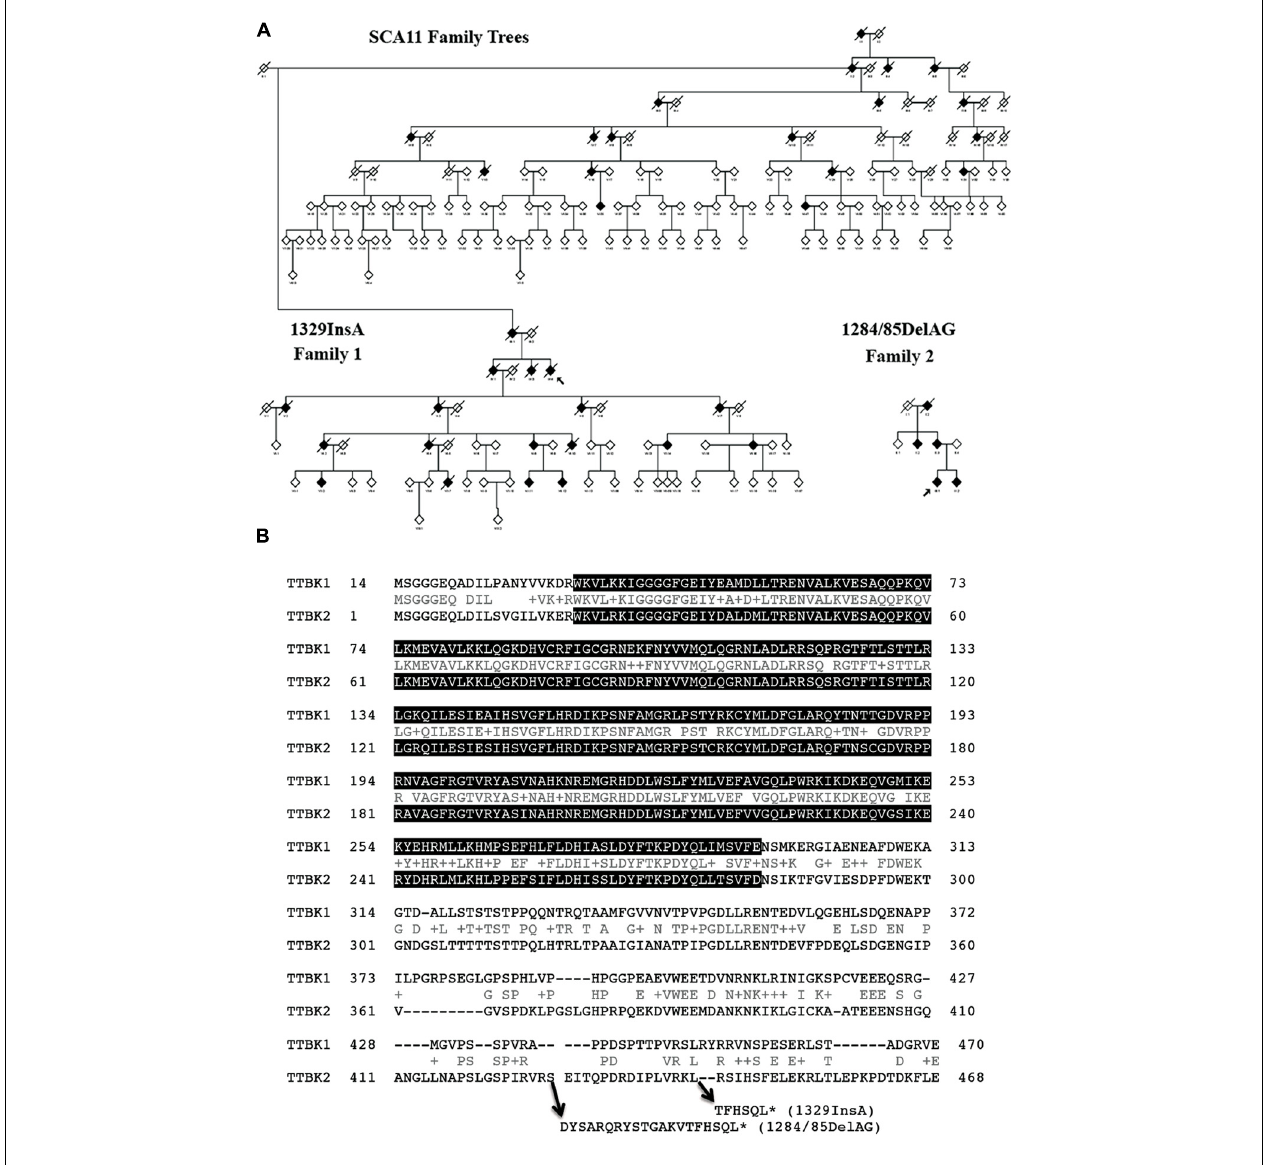
Houlden etal. (2007). (B) Sequence alignment of human TTBK1 and TTBK2 and sites of SCA11-linked TTBK2 mutations. Gray background shows putative catalytic domain (PHA02882). Accession number: BAE78660 (human TTBK1) and EAW92583 (human TTBK2). *Denotes translational